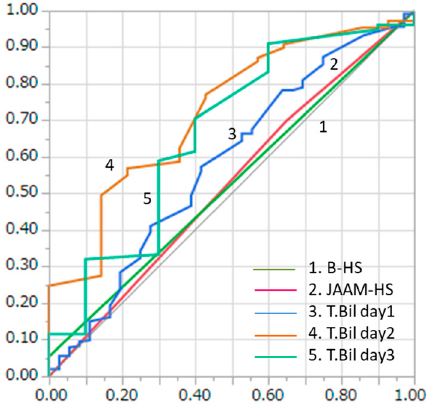
Figure 3. Comparison of AUC for neurological outcomes between the B-HS and JAAM-HS patients.